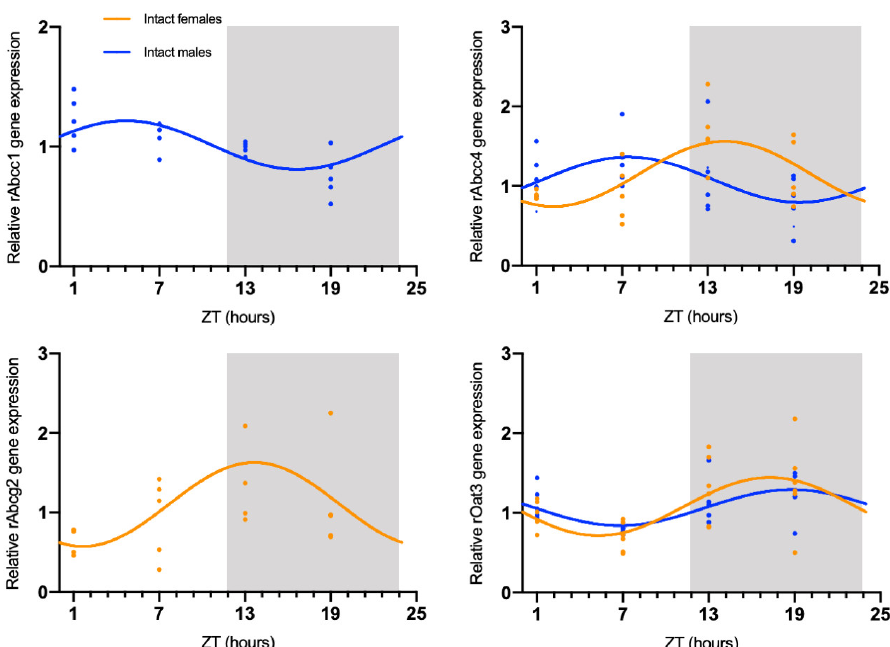
Figure 2. CircWave analysis of membrane transporters rAbcc1, rAbcc4, rAbcg2, and rOat3 mRNA circadian expression in the CPs of intact male and female rats. Absence of the CircWave curve indicates absence of significant rhythmicity as analyzed by CircWave. White and grey backgrounds represent the day and night periods, respectively. 2.2. hAbcc4 and hAbcg2 mRNA Circadian Expression in the HIBCPP Cell Line Because rAbcc4 showed daily oscillations in intact male and female rats and rAbcg2 showed daily oscillations in intact female rats, we also assessed the temporal expression of hAbcc4 and hAbcg2 mRNA in the human HIBCCP cell line. The results showed circa- dian variation (CircWave, p < 0.05) with a peak around 10 h after synchronization (Figure 3, Table 2). Figure 3. CircWave analysis of hAbcc4 and hAbcg2 expression profile in the HIBCPP cells . The rep- resented curve indicates a statistically significant rhythm (CircWave, p < 0.05).